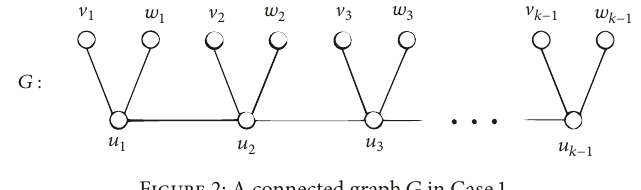
Figure 2: A connected graph 𝐺 in Case 1.